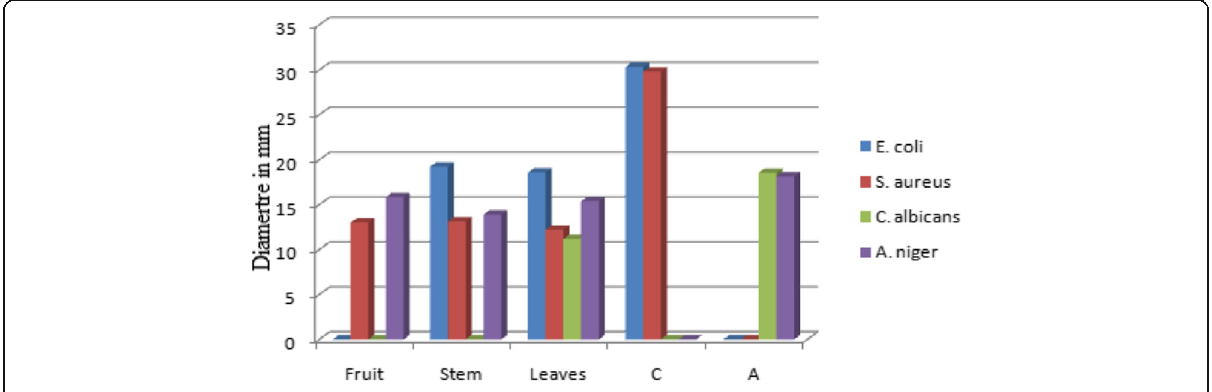
Fig. 1 An antimicrobial activity (diameter in mm) of Chloroform extract of fruit, stems, and leaves of Helicteres isora L. [12]